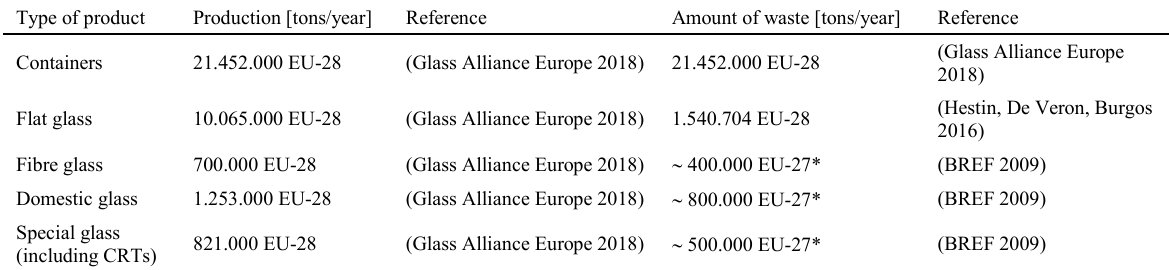
Table 1: Indices of glass waste production in EU from different industrial